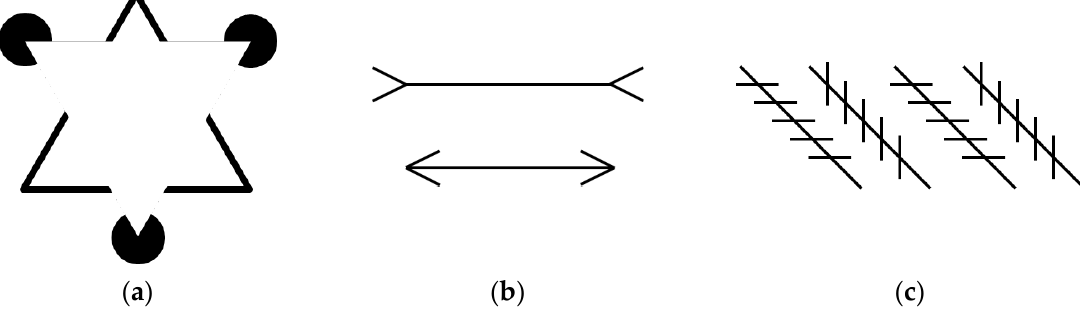
Figure 2. Visual illusion phenomena based on Gestalt theory. ( a ) Kanizsa triangle, ( b ) Müller – Lyer illusion, ( c ) Zellner illusion.